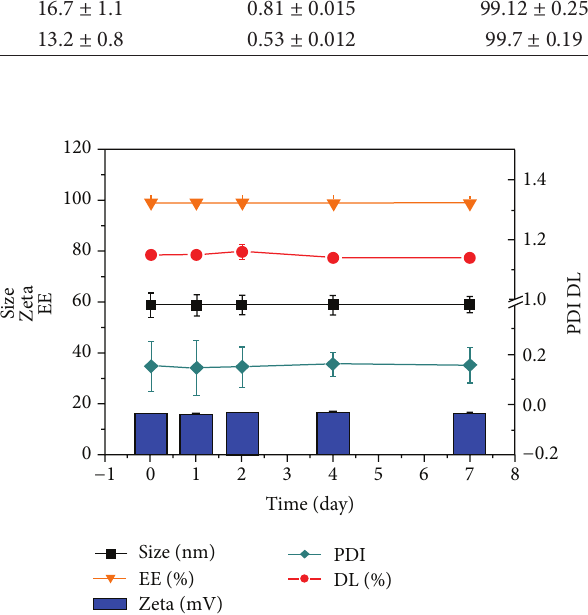
Figure 7: The stability of RGD/PTX liposomes in 7